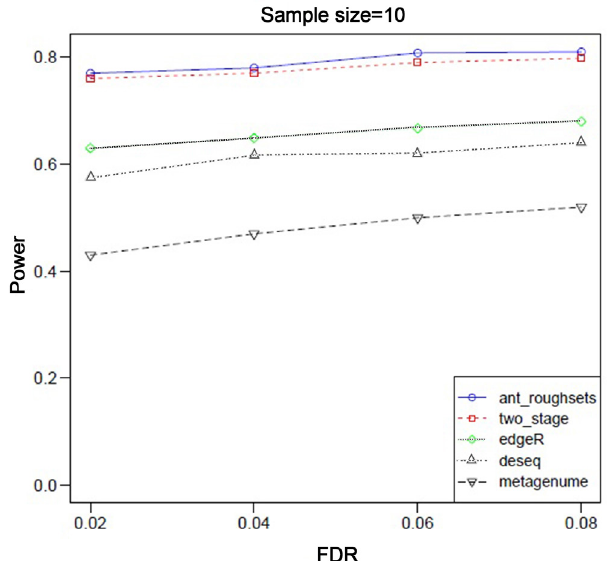
Fig. 12. The power in detection of the true differentially abundant genes for the five methods at various levels of FDR for sample size of 10.